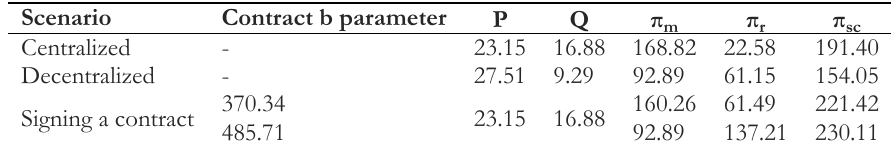
Table 8. The quantity of economic order, product price, and profit of firms’